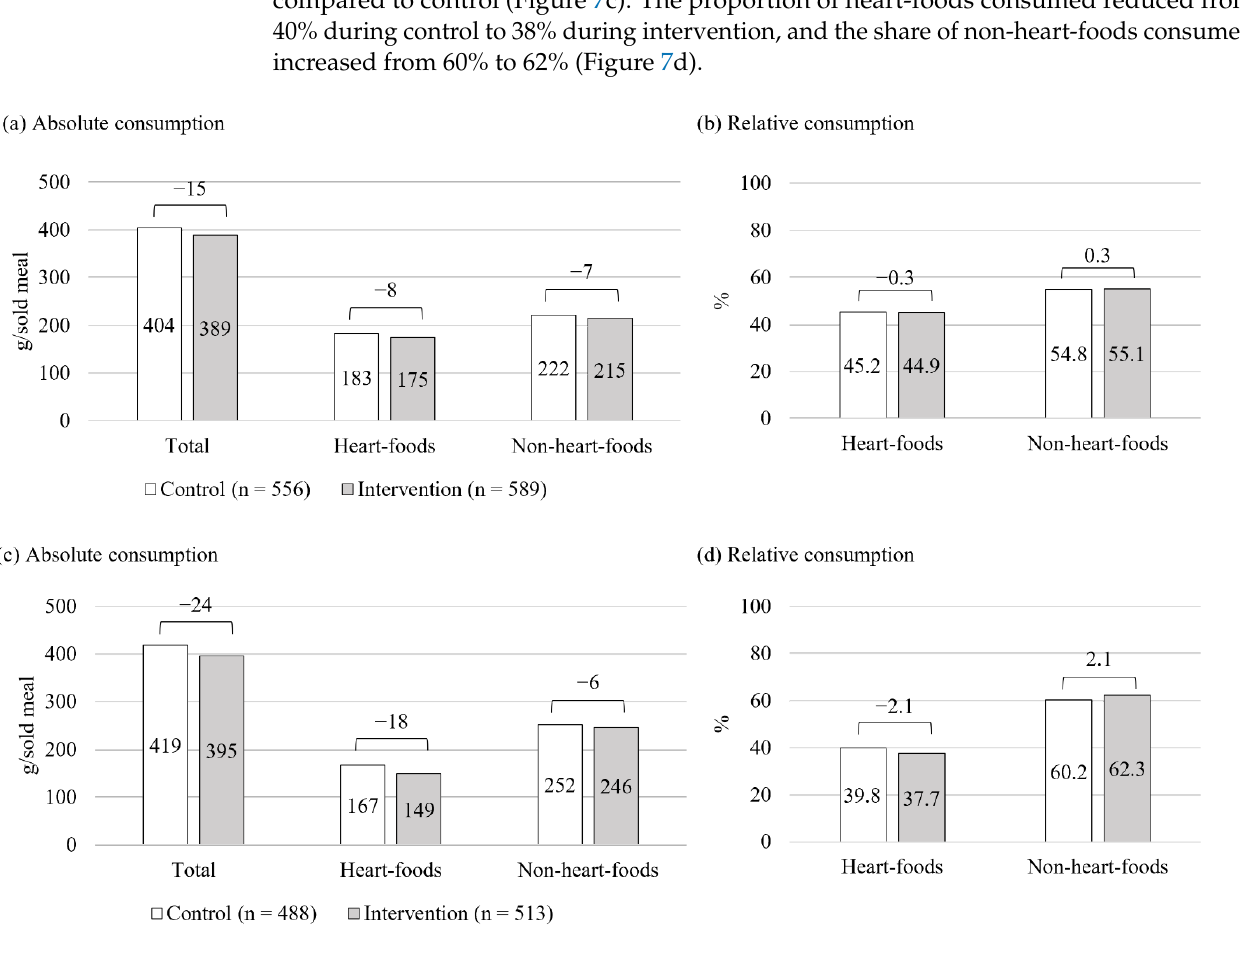
Figure 7. The cafeteria-level consumption of foods available on serving line stretch #2. ( a , b ) Data covers salad bar items, warm courses, and condiments; ( c , d ) Data covers warm courses and condiments. In graphs ( b , d ), numbers above the square brackets denote differences in percentage points.